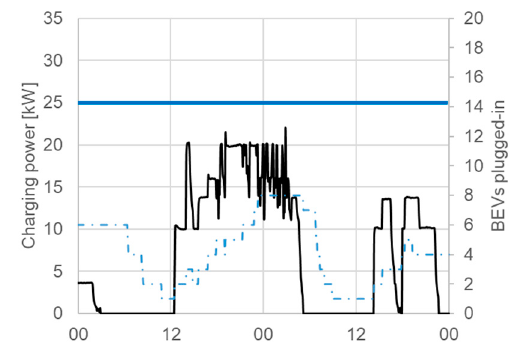
Figure 17. Load management with a maximum charging capacity of 25 kW (0.9 kW/BEV).